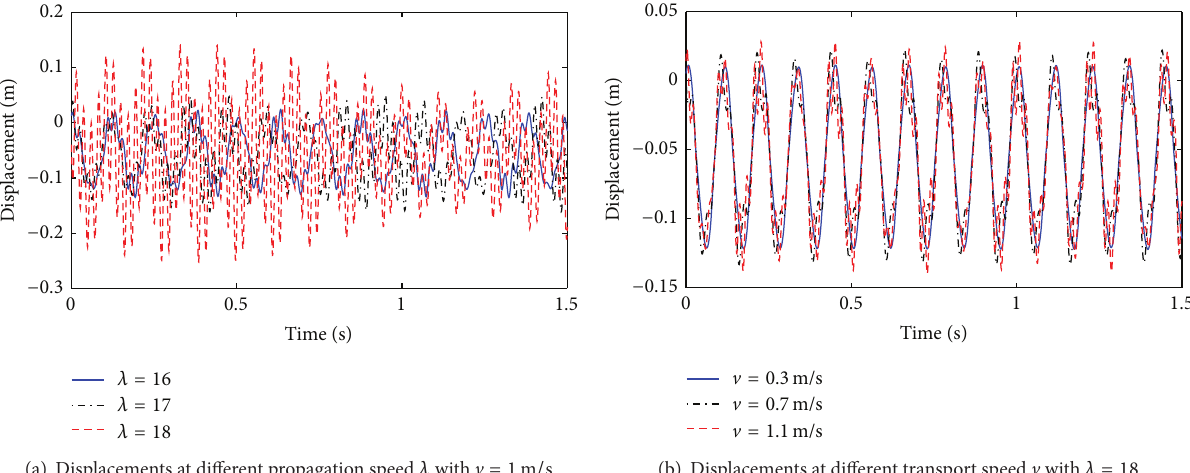
Figure 7: Total vibrations at the midpoint of the